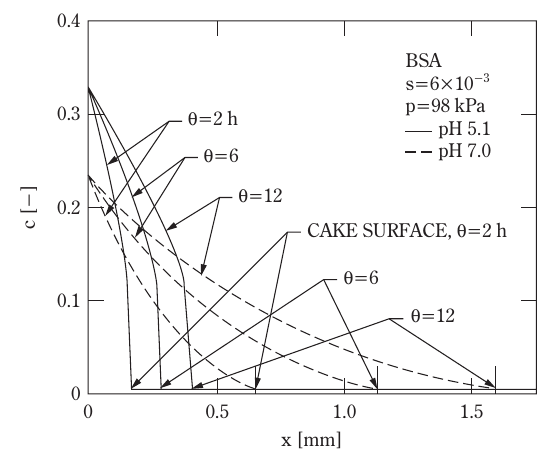
Fig. 11 Evaluation of distributions of solute concentration in filter cake based on ultracentrifugation